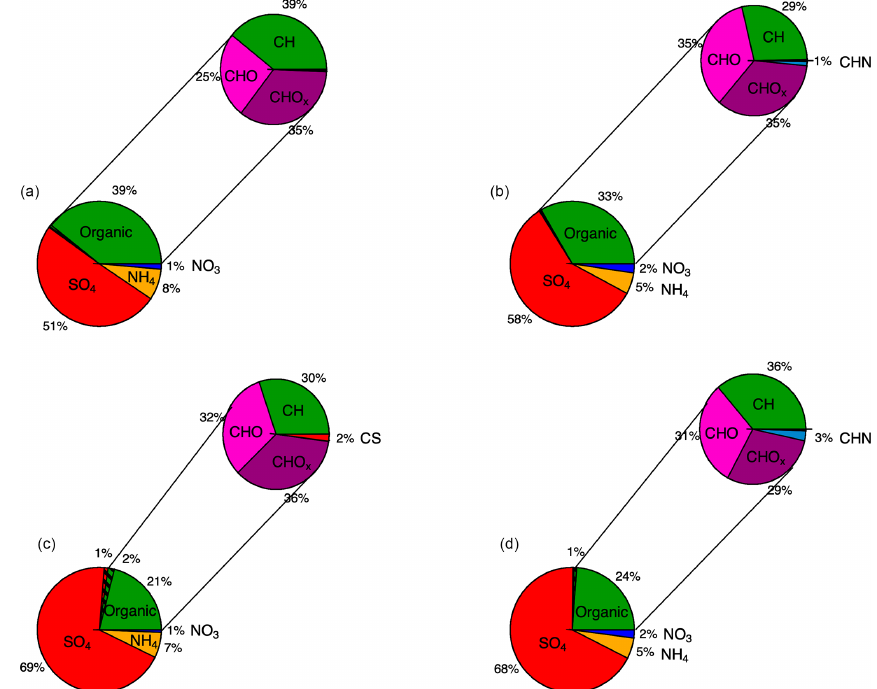
Figure 4. Relative contributions of four non-refractory components of aerosol chemistry: organic, sulfate, ammonium and nitrate to boundary layer AMS observations shown in Fig. 2 and Table 2 at two different altitude ranges. The hatched portions of organic and sulfate observations represent contributions of MSA. Also shown are relative contributions of different functional groups to the total organic budget. (a) 1000– 3000m, IOP 1. (b) 1000–3000m, IOP 2. (c) < 1000m, IOP 1. (d) < 1000m, IOP